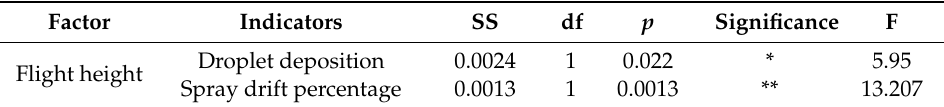
Table 4. Analysis of variance of droplet deposition and drift.